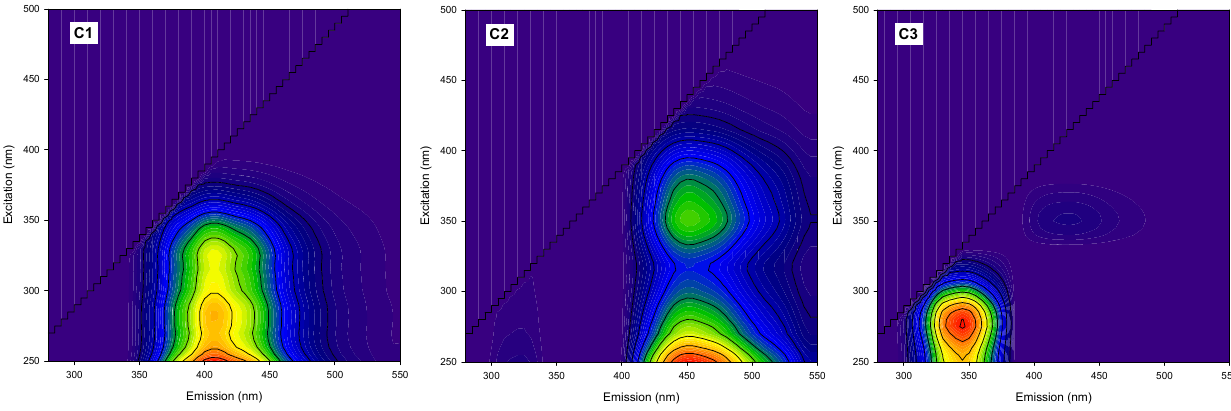
Figure 3. Contour plots of the three PARAFAC components decomposed from our samples.